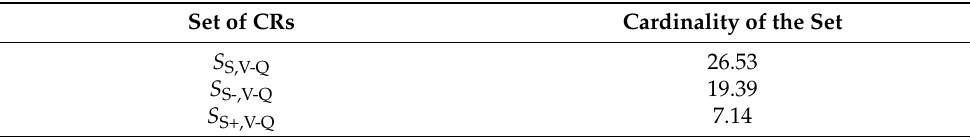
Table 3. The Numbers of SSCRs for the Particular Kinds of these CRs (in Percentage of All CRs, i.e., in Percentage of | S V-Q |).